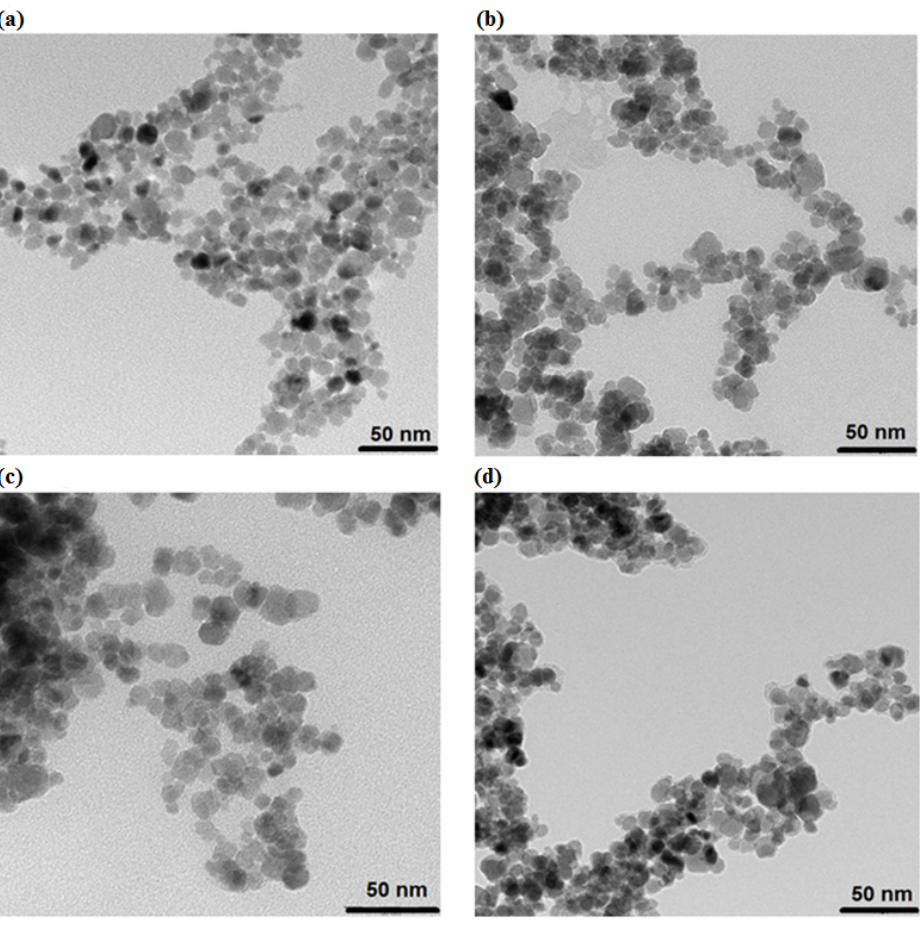
Figure 1. TEM images of particle size distributions ( a ) bare superparamagnetic iron oxide nanoparticles (SPIONs), ( b ) SPION@CA, ( c ) SPION@CA_Dox, and ( d ) SPION@CA_Epi (scale bar = 50 nm).